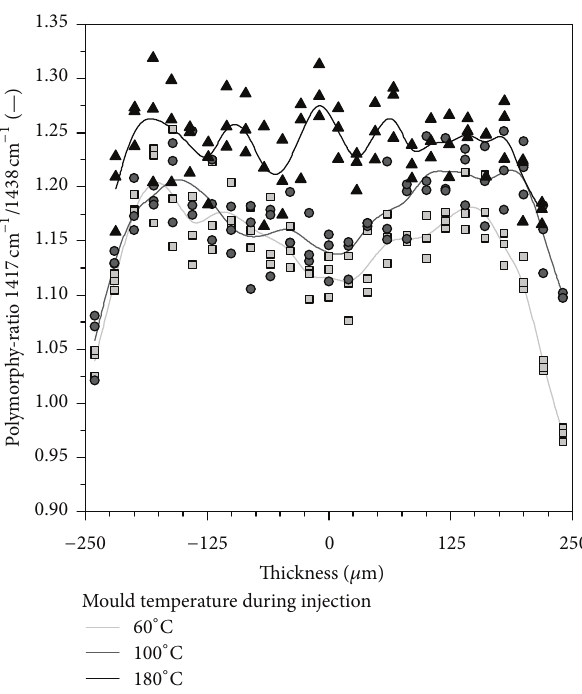
Figure 4: Degree of crystallinity over the cross section in depen- dence of process conditions.